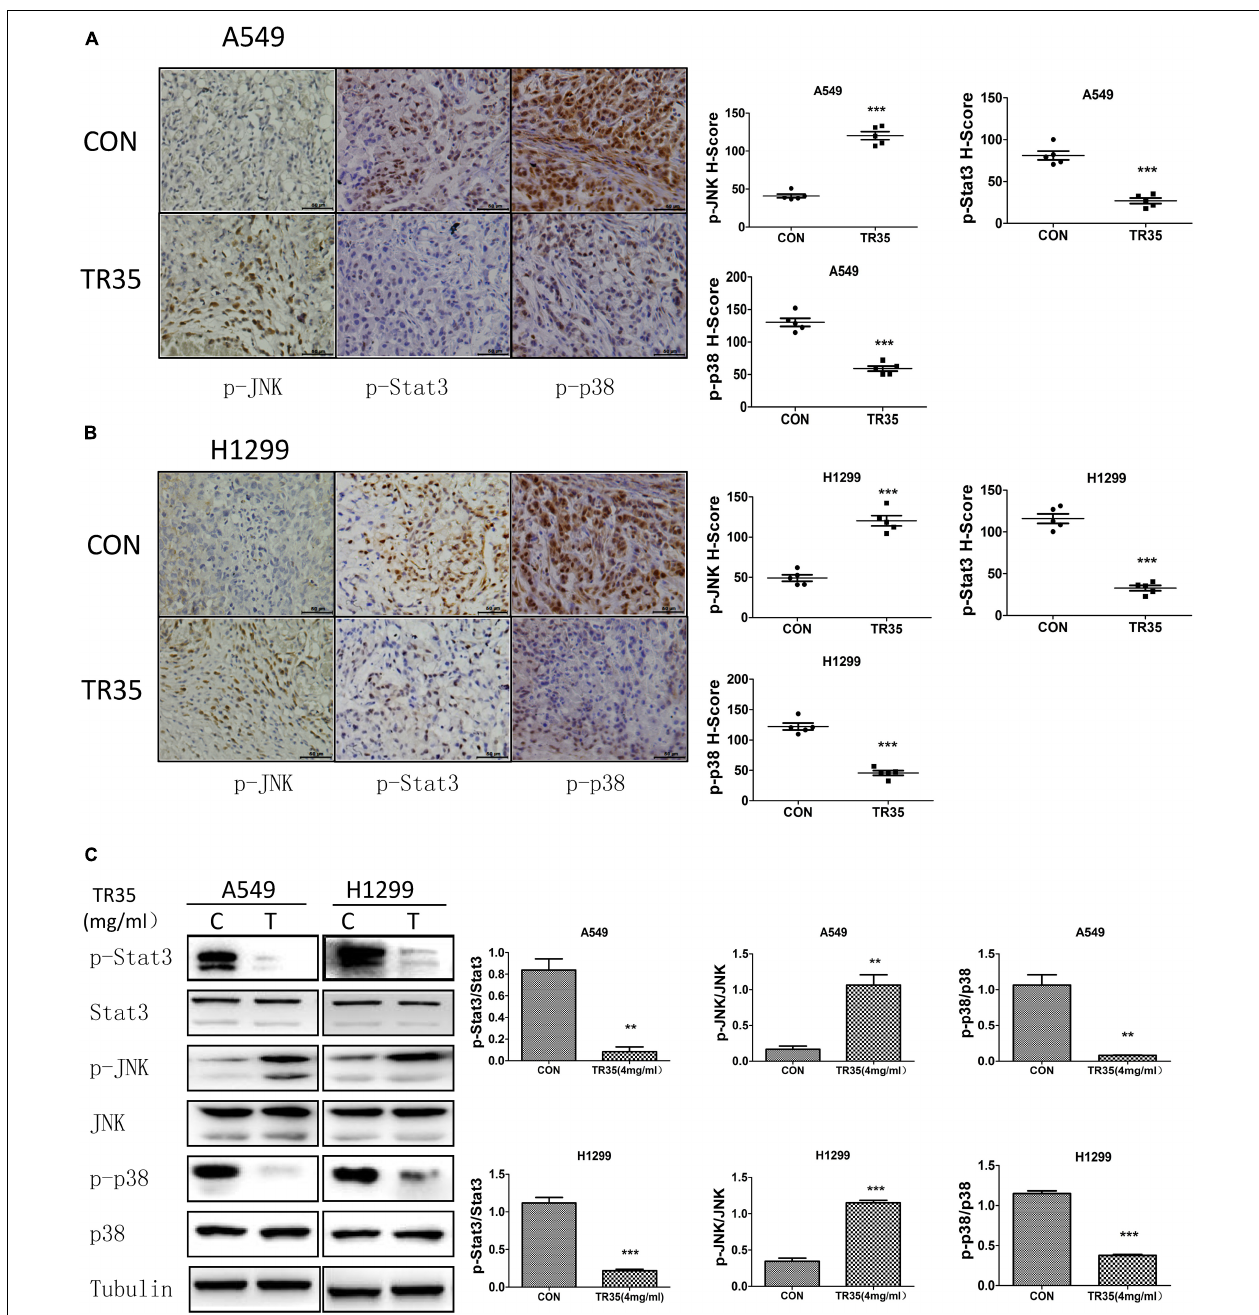
FIGURE 5 | Western blotting and Immunohistochemistry were used to evaluate the effect of TR35 on the expression of p-JNK, p-p38, p-STAT3 protein in dissected tumor tissue. (A,B) The expressions of p-JNK, p-p38, and p-STAT3 in dissected tumor samples formed by different cell lines were measured by IHC under a light microscope. Scale bar 50 µ m. (C) STAT3, p38, and JNK steady state and phosphorylated levels were analyzed in dissected tumor samples formed by different cell lines were measured by western blotting (** p < 0.01, *** p < 0.001 vs. CON).